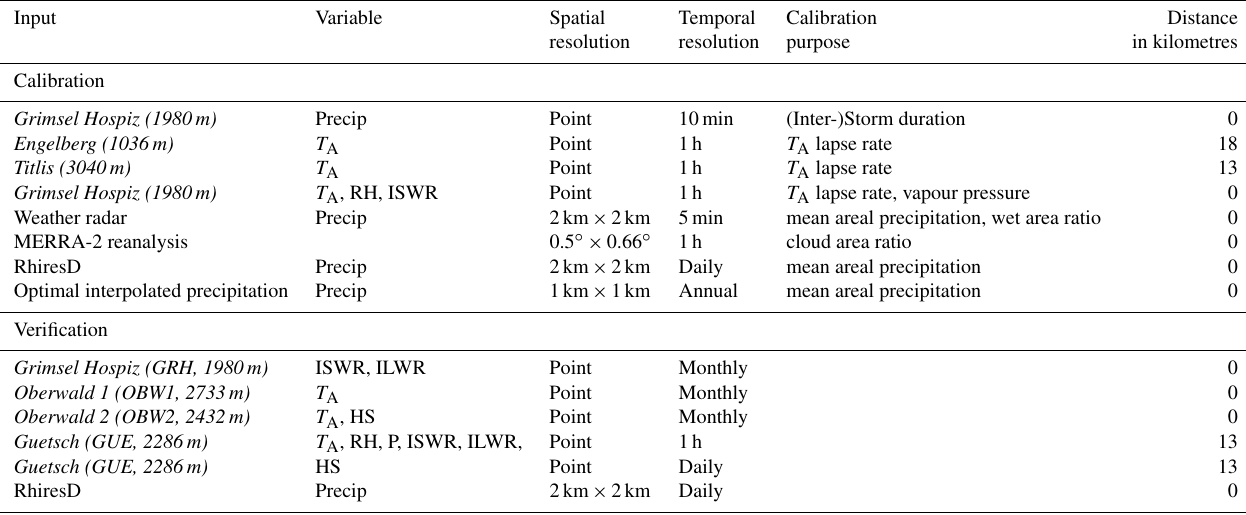
Table 1. Overview of observational data used for calibration and validation. The italic inputs are weather stations either within or with shown distance to the study area. T A is air temperature, RH is relative humidity, ISWR is incoming shortwave radiation, ILWR is incoming longwave radiation, P is air pressure, Precip is total precipitation, and HS is snow depth.